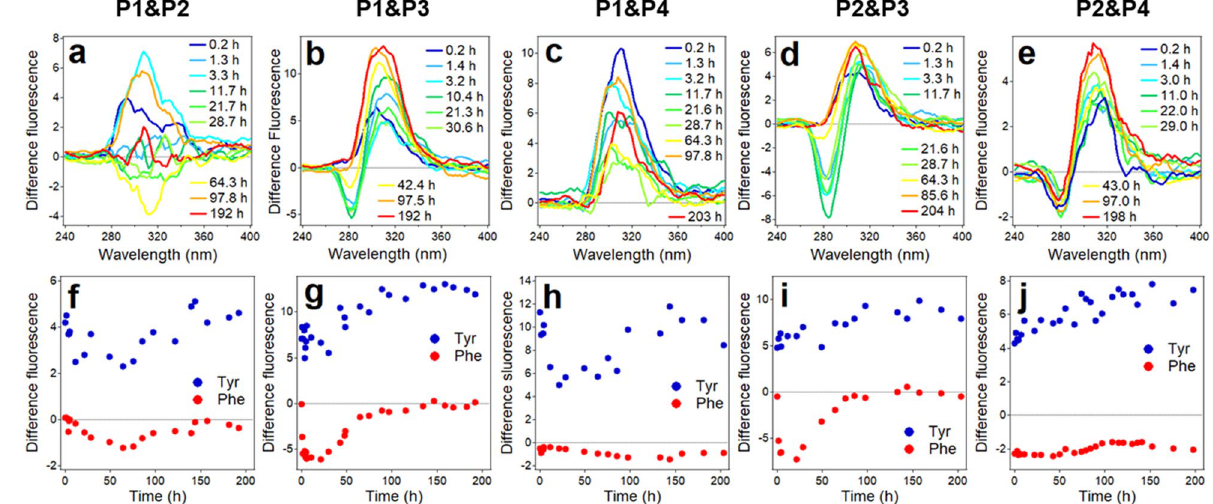
Figure 8. Fluorescence resonance energy transfer difference spectra ( a through e ) and values for tyrosine and phenylalanine, averaged between 300 and 320 nm for tyrosine and 270 and 290 nm for phenylalanine ( f through j ) for five peptide systems, as indicated at the top. Fluorescence spectra have been smoothed by 13-point Savitzky–Golay least-squares polynomial algorithm before subtraction. See details in “Materials and